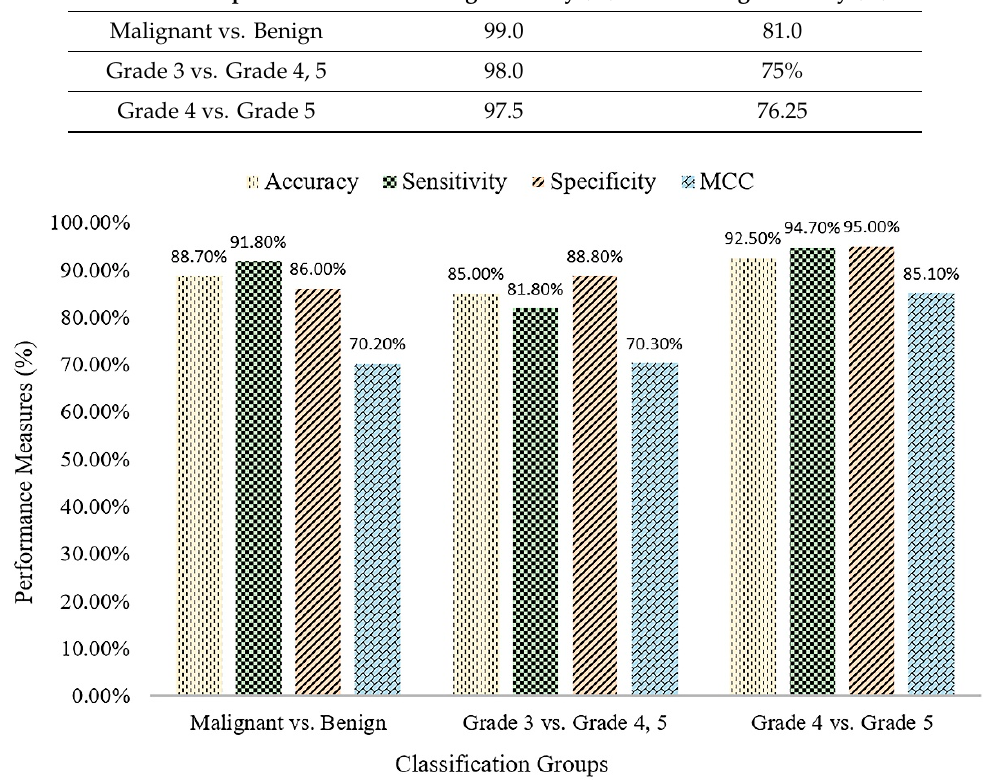
Figure 7. Comparison graph of support vector machine (SVM) classification accuracy among three binary divisions. The classification accuracies of the three groups are very close to each other, and the highest accuracy obtained was 92.50%, for grade 4 vs. grade 5. Matthew’s correlation coefficient (MCC) indicates the quality of binary classification among the three classification groups.